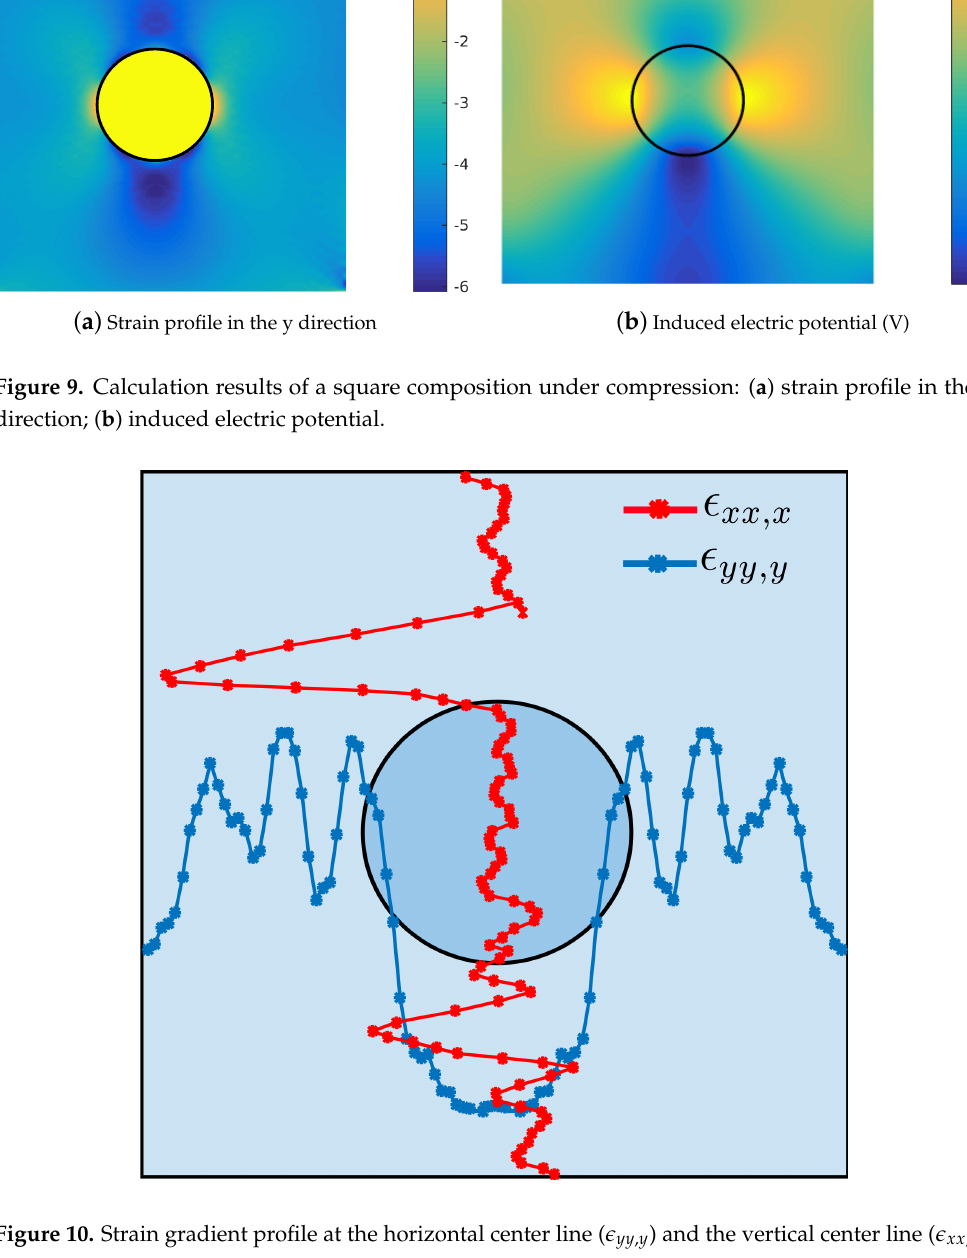
Figure 10. Strain gradient profile at the horizontal center line ( (cid:101) yy , y ) and the vertical center line ( (cid:101) xx , x